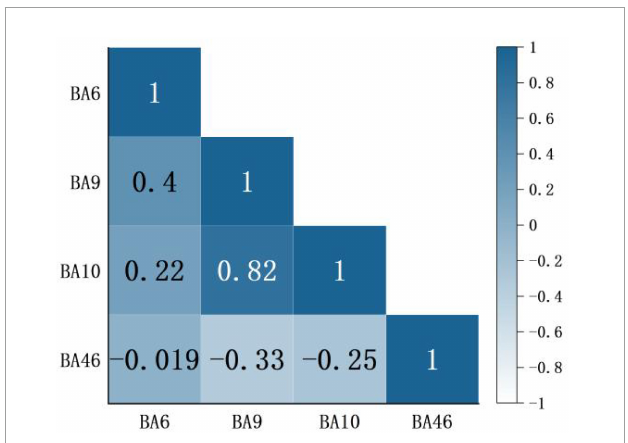
FIGURE7 A correlation of regions of interest (ROI) brain region in the condition of music intervention. Red represents a positive correlation, blue represents a negative correlation, and darker color means a more significant correlation. The number indicates the correlation coefficient r. Usually | r | ≥ 0 . 7 defined as high correlation, 0 . 3 < | r | < 0 . 5 defined as low correlation, and | r | ≤ 0 . 3 defined as no correlation.